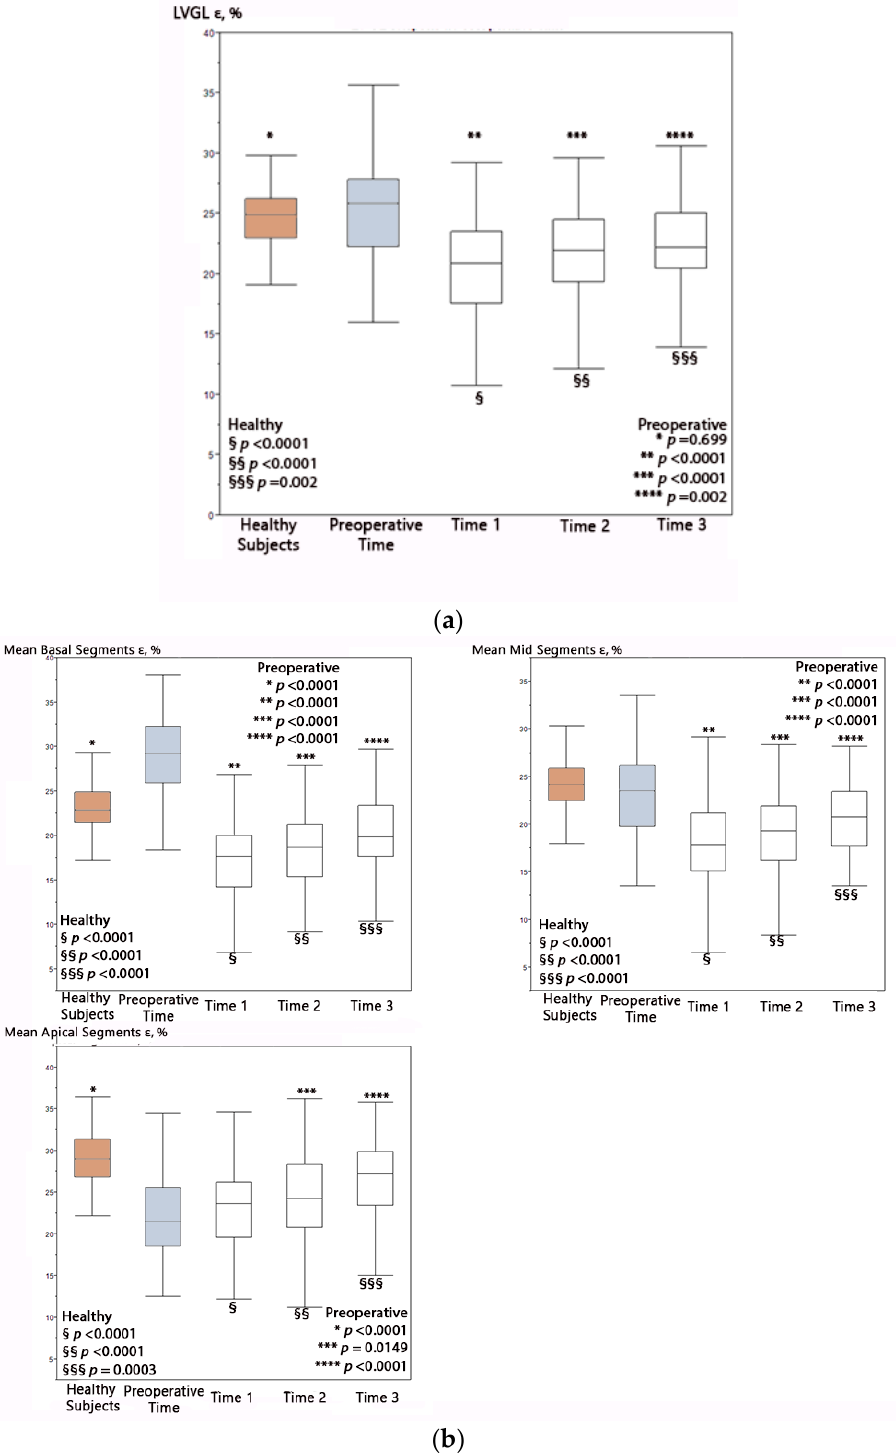
Figure 1. Median and interquartile range of global ventricular ε values over time in the overall population. On the left are the i values of the differences among healthy subjects (brown box) and different pre- and postoperative times, while on right, the i values of differences among preoperative time (gray box) and postoperative times and healthy subjects are shown: ( a ) global LV ventricular ε values; ( b ) segmental LV ventricular ε values. Bold horizontal line = median; box = interquartile range. LVGL = left ventricle global longitudinal